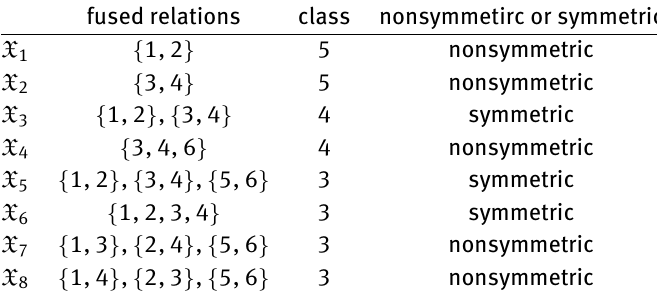
fused relations